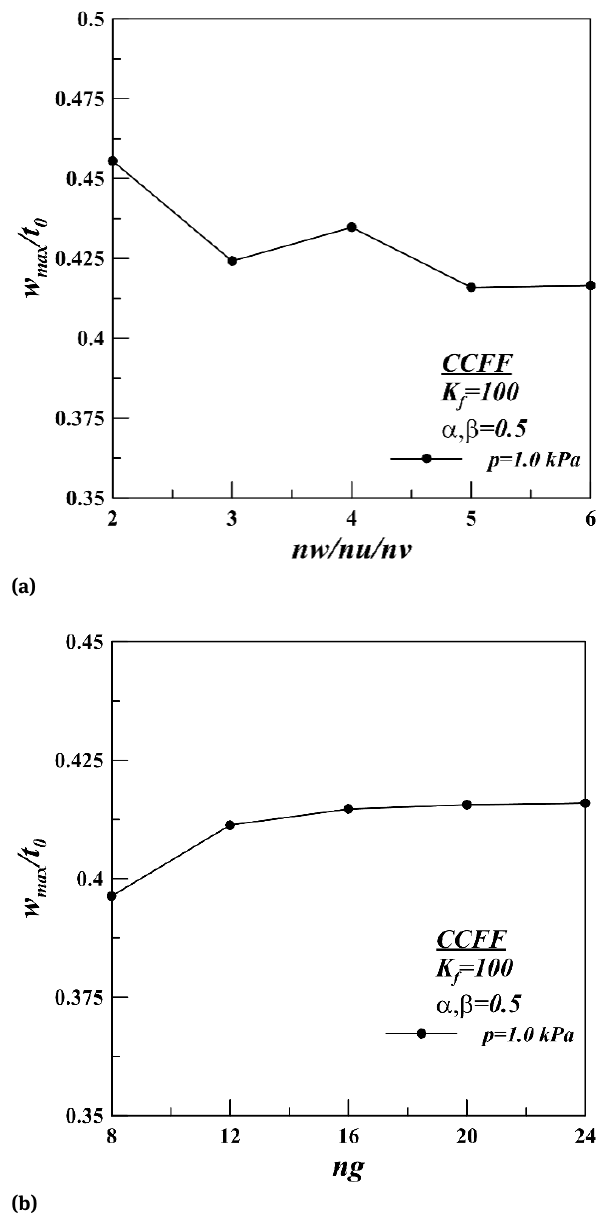
Figure 2: Convergence study for (a) no. of orthogonal functions (b) gauss point